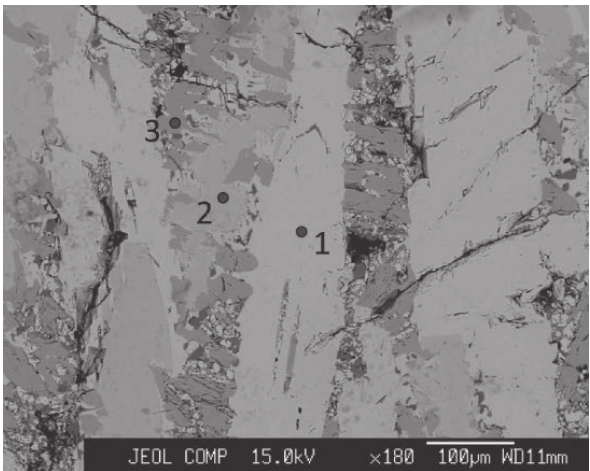
Fig. 7: Backscattered electron micrograph of CMS-HC slag, near the top of the crucible. Points: 1 = melilite, 2 = monticellite. Note the large voids, indicating bubbling at higher